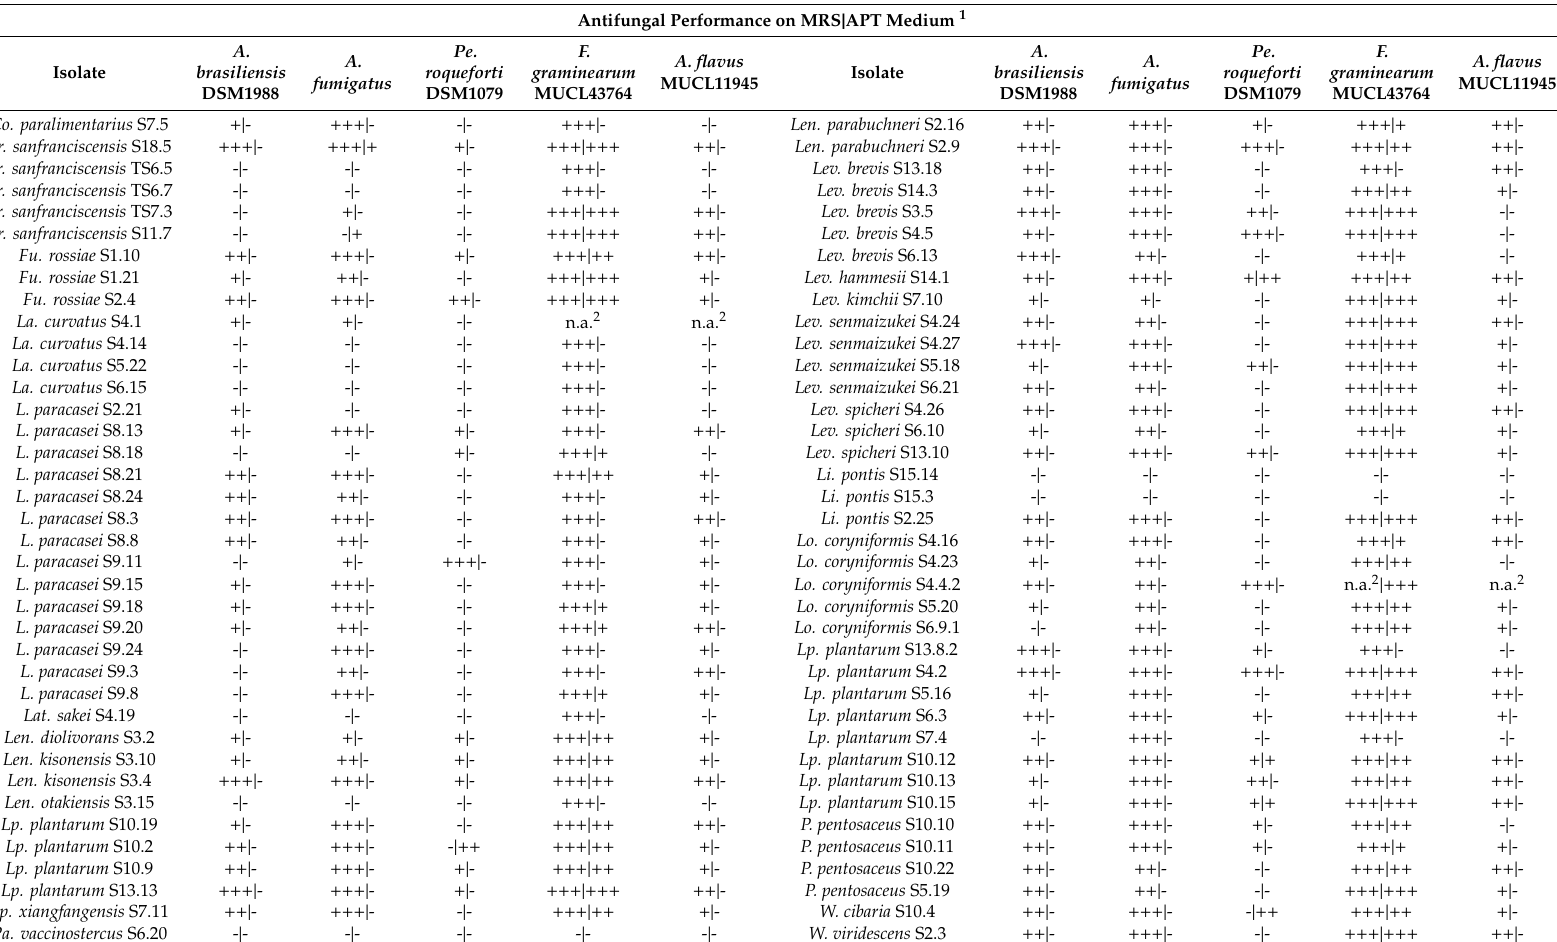
Table 2. Antifungal activity of lactic acid bacteria exerted on MRS (de MAN, ROGOSA and SHARPE; left of the vertical bar) and APT (all-purpose tween; right of the vertical bar) medium against Aspergillus brasiliensis DSM1988, A. fumigatus , Penicillium roqueforti DSM1079, Fusarium graminearum MUCL43764, and A. flavus